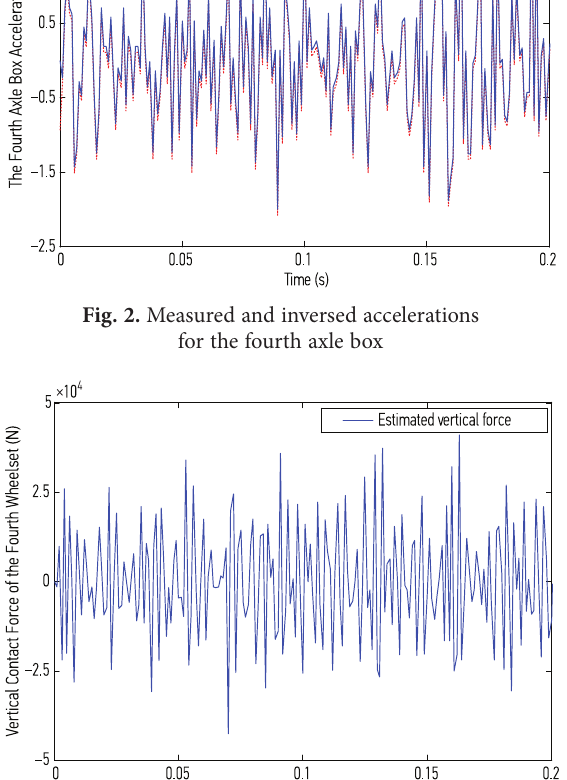
Fig. 3. The estimated vertical dynamic contact force for the fourth